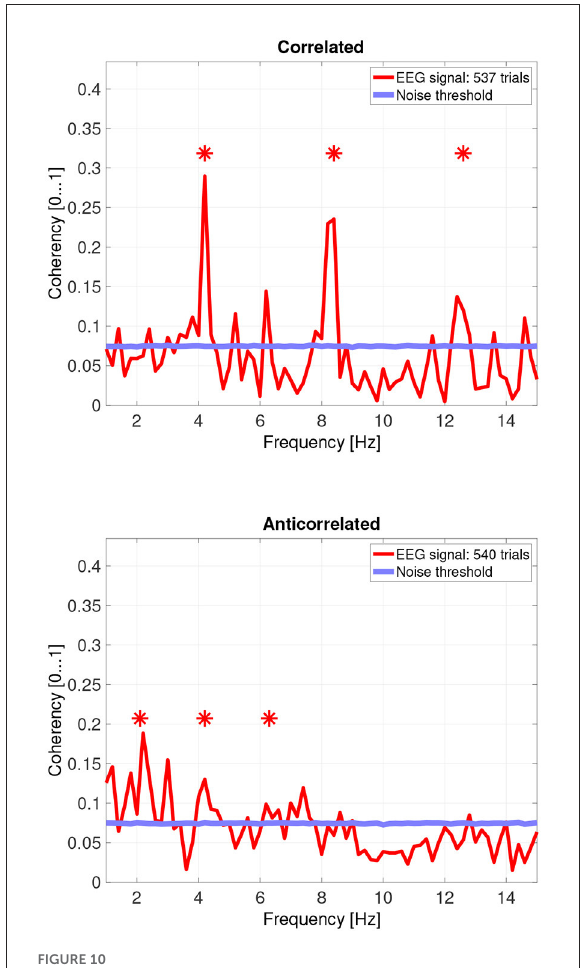
FIGURE10 Coherency values of the pooled trials from four participants. The stars above the peaks indicate successful detection of the harmonic of the stimulus frequency. Note that the coherency plots are in phase space, and that they are not showing spectrum: a higher coherency value imply a stronger relationship to the stimulus. The “Noise threshold” is created with 10,000 data sets having the same number of trials, with the trials containing only white noise. The line shows the 95 th percentile of the coherency values created from these synthetic data